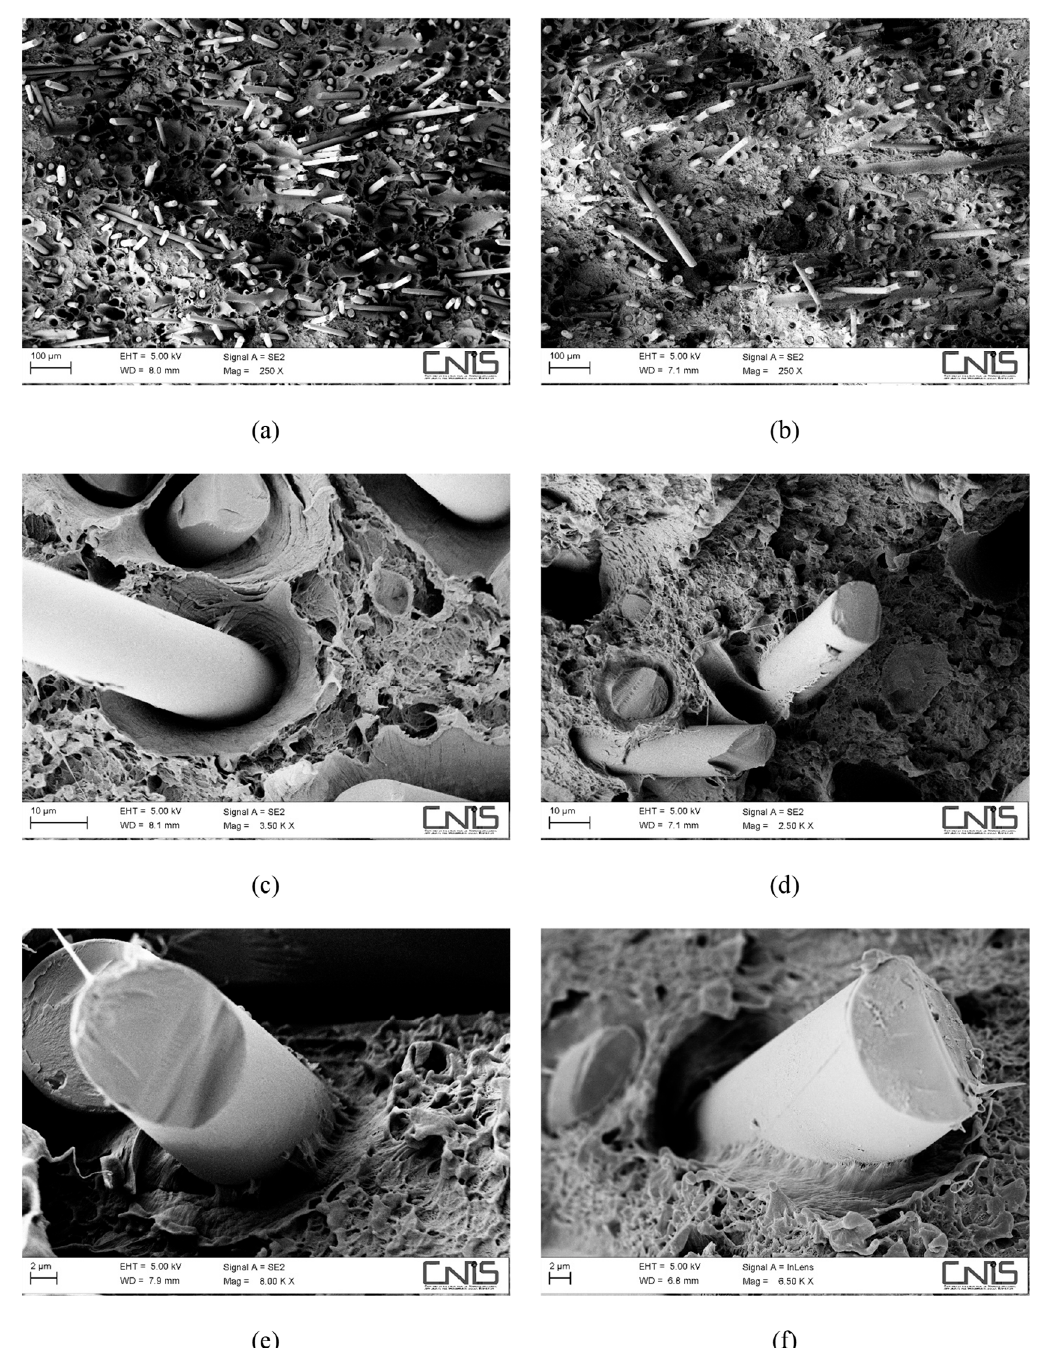
Figure 4. SEM micrographs detailing the fracture surface of water-aged composites, reinforced with 30 wt % of basalt fibres without ( a , c , e ) and with ( b , d , f ) a coupling agent.